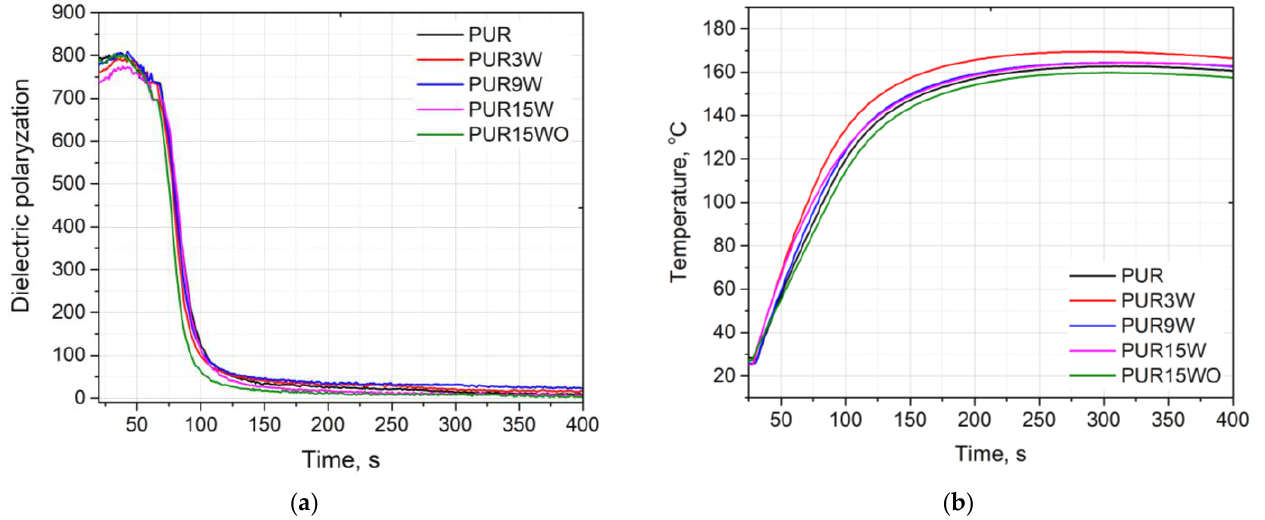
Figure 5. Influence of vermiculite on dielectric polarization ( a ) and temperature ( b ).